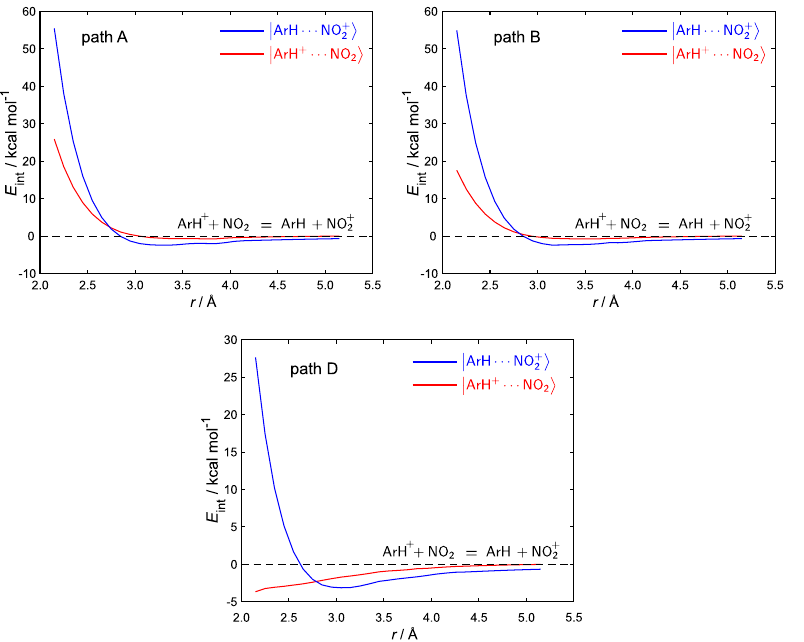
Figure 5. Predicted interaction energy of toluene/toluene + with NO + function of the distance of the interacting units, oriented as in the paths A, B, and D of Figure